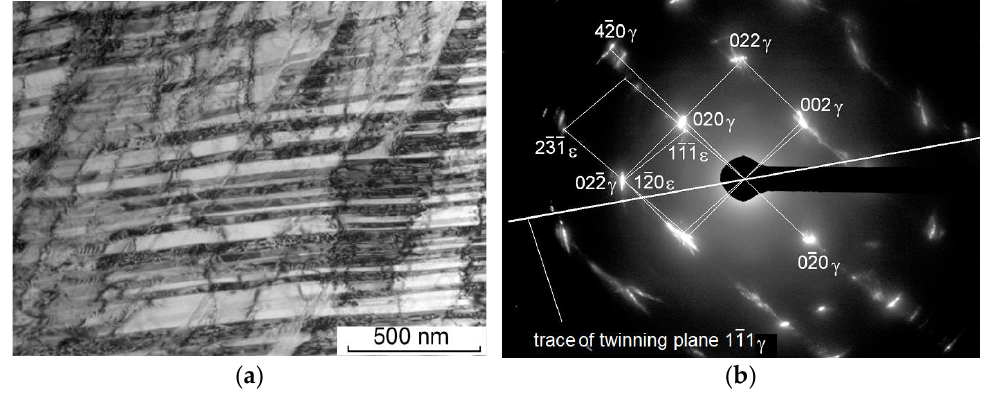
Figure 2. The microstructure of Cr-Mn-N steel after the tensile test at T = −1 96 °C ( a ) and the electron diffraction pattern of γ -phase (z = [100] γ and z = [120] γ ) as well as ε -martensite z = [211] ε ( b ). The reflection from (101) ε plane was also observed in the corresponding diffraction pattern (Figure 3).